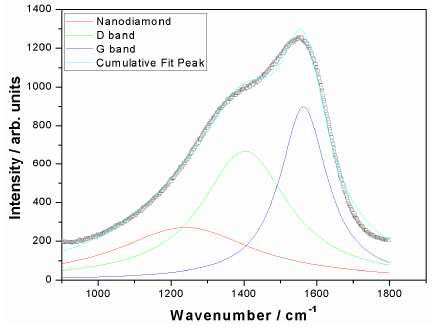
Figure 3. Typical Raman spectrum of carbon films synthesized by PLD in vacuum at 2 J/cm 2 laser